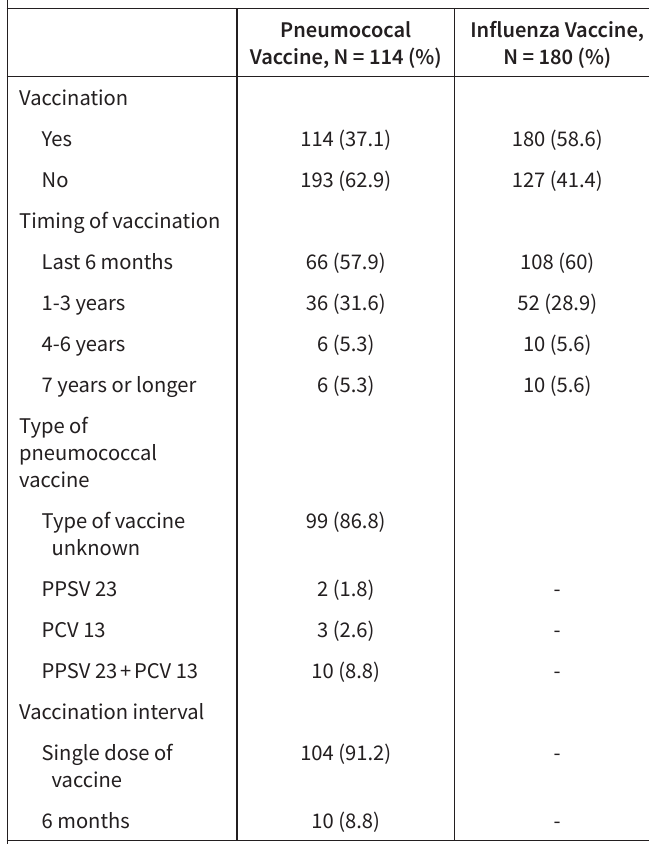
Table 2. Demographic Characteristics of the Dialysis Patients Table 3. Information About Pneumococcal and Influenza